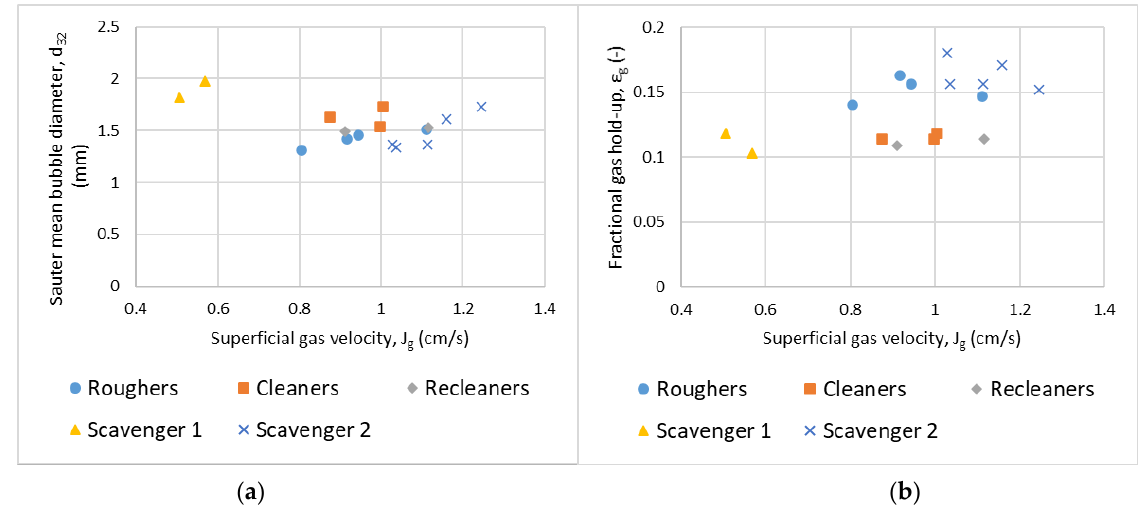
Figure 2. Hydrodynamic measurements for bank B represented as ( a ) Sauter mean bubble diameter as a function of superficial gas velocity, and ( b ) fractional gas hold-up as a function of superficial gas velocity.